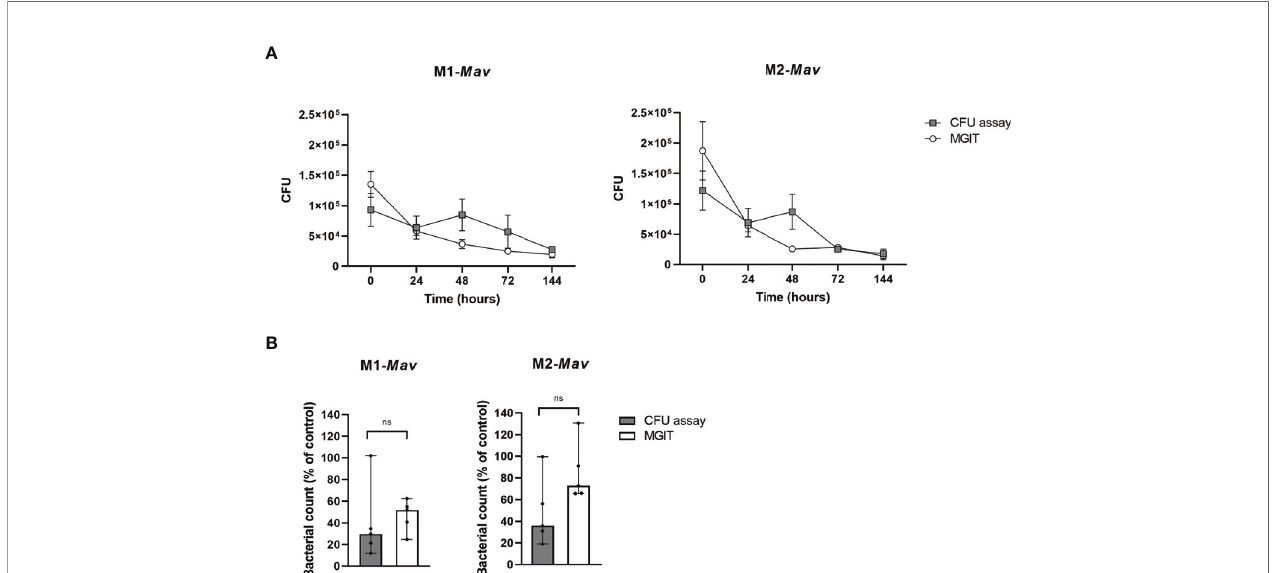
FIGURE 3 | Quanti fi cation and comparison of infection with and eradication of intracellular Mav Wasabi by CFU enumeration based on agar plate assay and the MGIT system in primary human macrophages (A) . Validation of the MGIT system to determine antibiotic ef fi cacy in primary human macrophages infected with Mav Wasabi (B) . To assess the MGIT system as a valid enumeration technique of intracellular bacteria, pro-in fl ammatory macrophages (M1) or anti-in fl ammatory macrophages (M2) were infected with an MOI 10 of Mav Wasabi for 1 h. After infection and during prolonged incubation, intracellular bacterial loads were quanti fi ed using the classical CFU assay and the MGIT system (A) . The MGIT system was validated for its use for drug testing by treating Mav -infected M1 and M2 (10:1) with rifampicin (20 m g/ml) or control (DMSO) for 24 h (B) . After treatment, cells were lysed and CFU numbers in lysates were determined by using the classical CFU assay and the MGIT assay. The symbols and whiskers represent the mean ± SEM of counted (gray boxes) and MGIT-based (open circles) CFU numbers ( n = 3) (A) , whereas the bars and error bars represent the median ± range ( n = 5) (B) . CFU numbers determined by either the CFU assay or MGIT were signi fi cantly correlated (Spearman r : 0.78; p -value = 0.011) (A) and Wilcoxon matched-pairs signed rank tests with Holm-Sidak multiple comparison testing was used to compare compound-induced effects between both methods (B) . Ns, non-signi fi